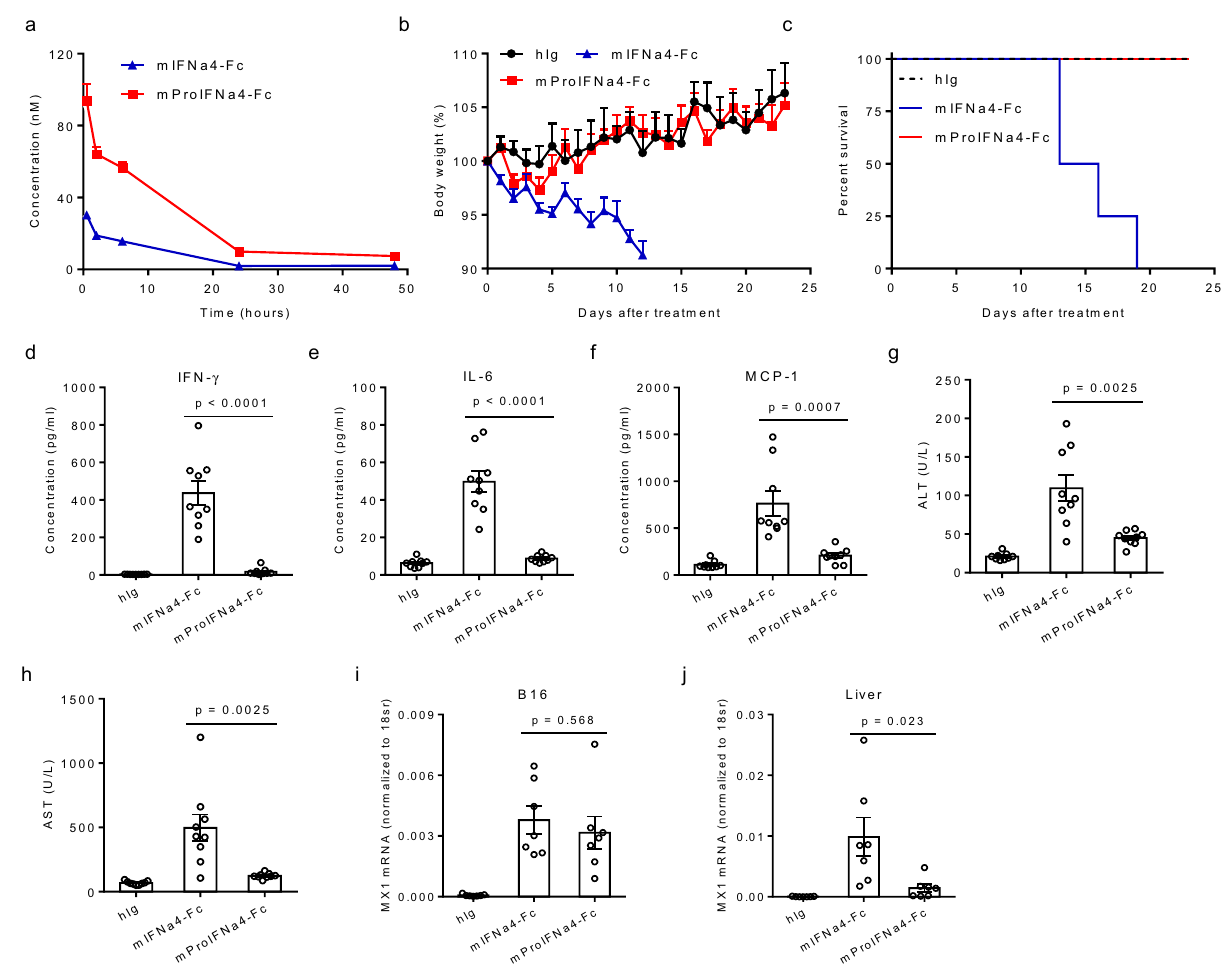
Fig. 2 In vivo assessment of toxicity. a The pharmacokinetics of mProIFNa4-Fc and mIFNa4-Fc were compared in C57BL/6 mice following one intravenous (i.v.) dose at 1 nmol ( n = 4 animals). b , c Healthy C57BL/6 J mice were intraperitoneally (i.p.) treated with 1 nmol of hIg, mIFNa4-Fc, or mProIFNa4-Fc, every 3 days for 6 times ( n = 4 animals). Body weight ( b ) and survival curve ( c ) were shown. d – h Healthy C57BL/6 J mice were intraperitoneally (i.p.) treated with 1 nmol of hIg, mIFNa4-Fc, or mProIFNa4-Fc, every 3 days for three times ( n = 9 animals). Plasma samples were collected 2 days after the last treatment. The levels of IFN- γ ( d ), IL-6 ( e ) and MCP-1 ( f ) were quanti fi ed by cytometric bead array (CBA). The levels of ALT ( g ), AST ( h ) were determined by UTSW Metabolic Phenotyping Core. i , j C57BL/6 J mice were s.c. inoculated with 5 × 10 5 B16 cells and i.p. treated with 1 nmol of hIg, mIFNa4-Fc, or mProIFNa4-Fc on day 11 ( n = 7 animals). Liver and tumor tissues were harvested 48 h after treatment. Intracellular RNA was extracted for RT-qPCR assay to determine expression levels of MX1 in B16 tumors ( i ) and livers ( j ). Data are reported as mean ± s.e.m. Two-tailed t -tests were performed to calculate p -values. Source data are provided as a Source Data fi